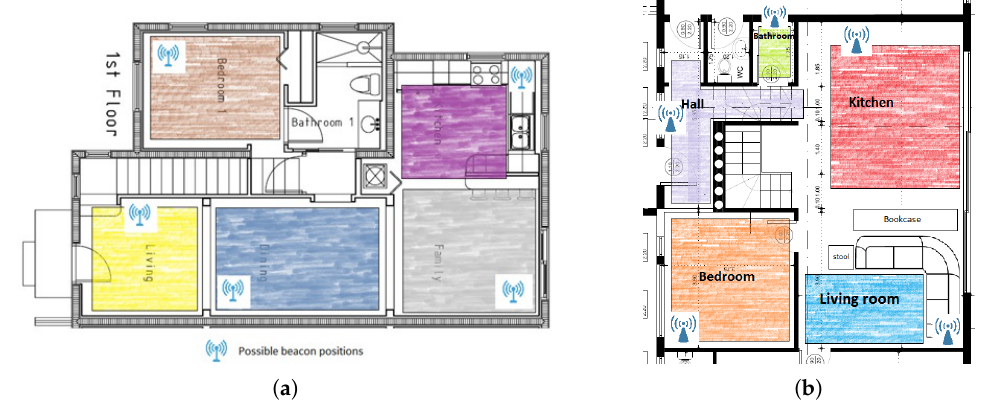
Figure 3. ( a ): Example of a beacon topology in a house. ( b ): Example of a beacon topology in the KRIPIS Smart Home [40] at CERTH/ITI, were the system was evaluated. With different colors are the areas where the user, performing beacon setup procedure, should walk for half a minute in order to create the signal fingerprint for each